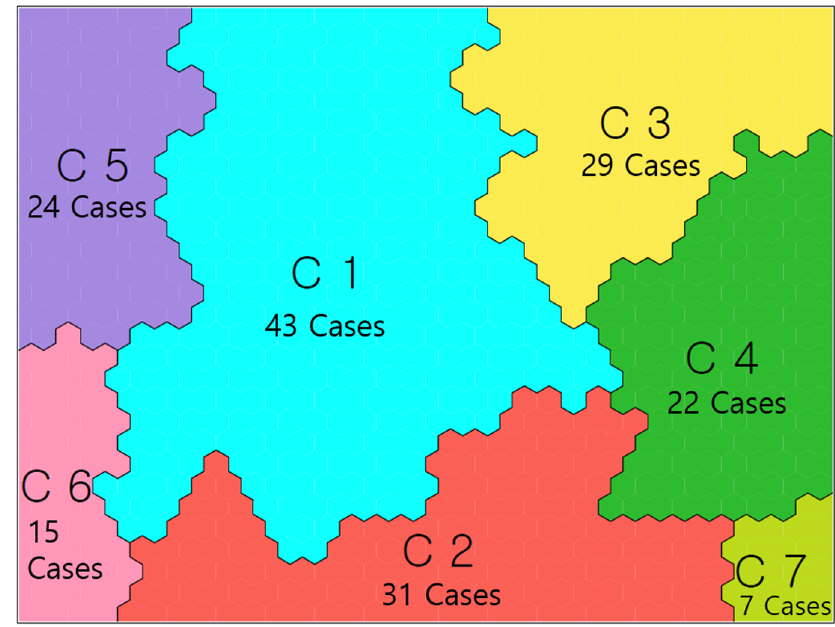
Figure 1. U-Matrix for 171 smart farm